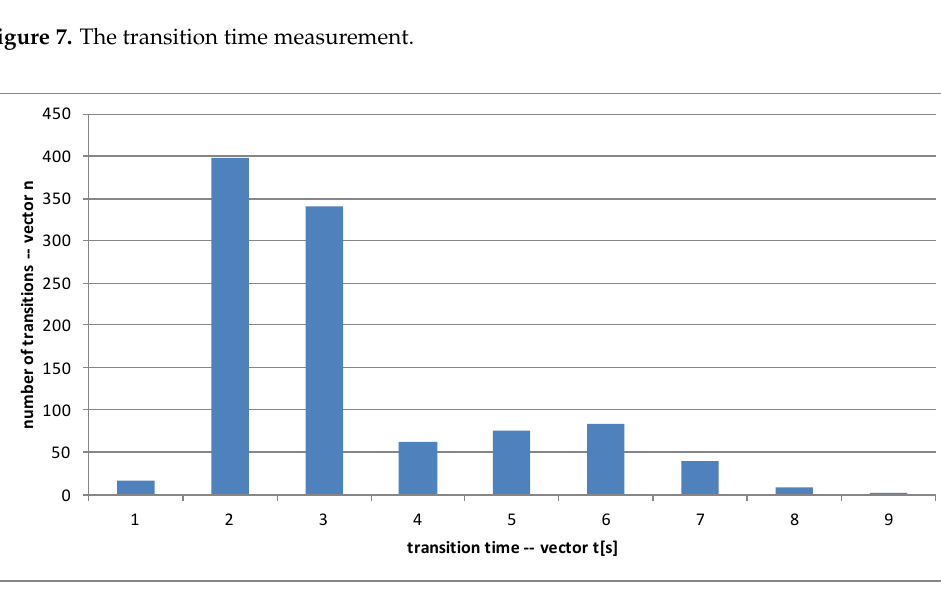
Figure 8. Histogram n of transition time.